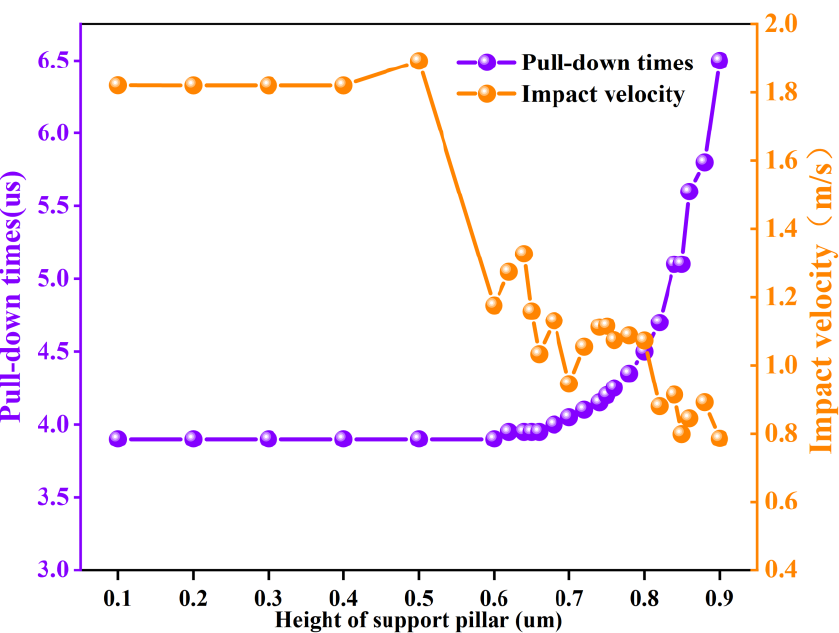
Figure 11. Effect of changing the height of the support pillars on impact velocity and pull-in time.